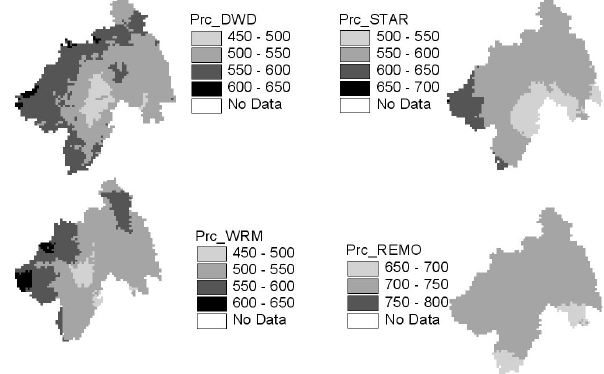
Fig. 6. Spatial distribution of mean annual rates of precipitation in mmy − 1 obtained from German Weather Service (=Prc DWD) and calculated from climate change scenarios STAR (=Prc STAR), Wettreg middle (=Prc WRM) and REMO (=Prc REMO), all based on the time period